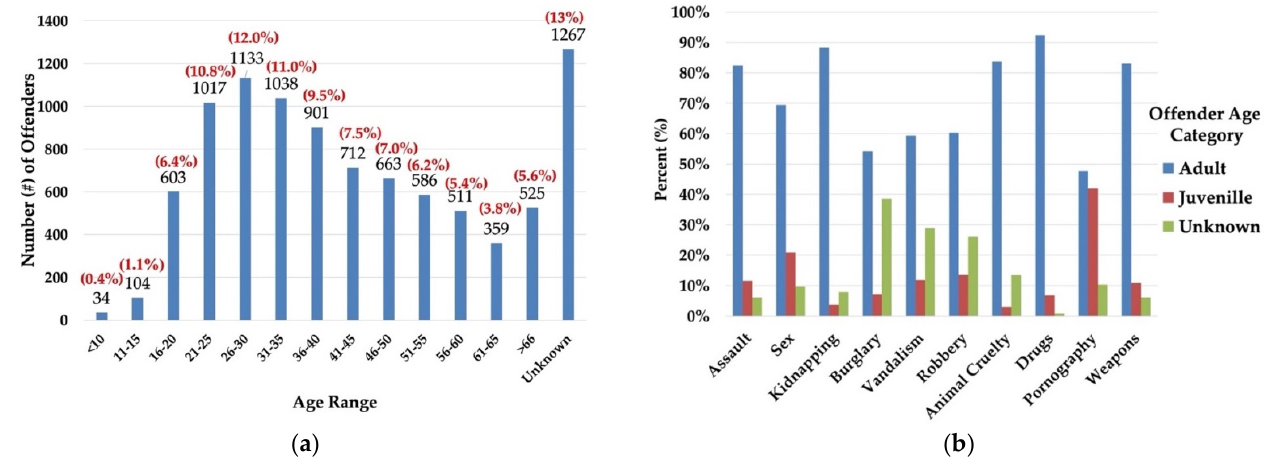
Figure 6. ( a ) Animal Cruelty Offenders by Age Range; ( b ) 2019 Adult and Juvenile Offenders vs. Offense Type.